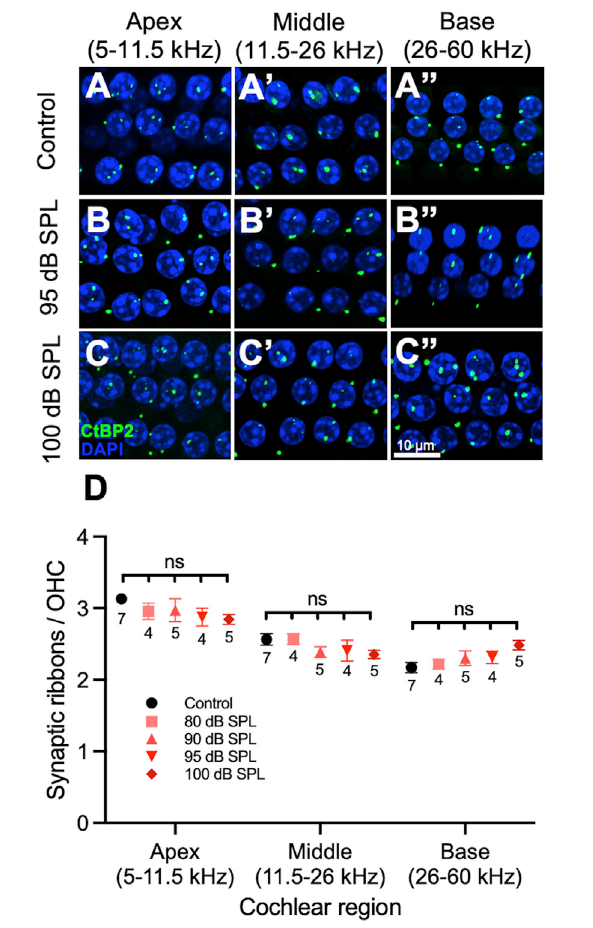
FIGURE 4 | 2 h noise exposure has no effect on outer hair cell (OHC) ribbons. (A – C) Representative sections from the organ of Corti of mice 7 days after noise or sham exposure (control) displaying 3 rows of 4 OHC nuclei and associated ribbons. Immunolabeling was performed to visualize OHC ribbons (CtBP2, green) as well as nuclei (DAPI, blue). Control mice (A) ,miceexposedto95decibel(dB) soundpressurelevelSPL (B) ,and mice exposed to 100 dB SPL (C) had similar numbers of ribbons per OHC. (D) Quanti fi cation of ribbons per OHC. There were no signi fi cant differences in the number of ribbons per OHC between mice exposed to 80, 90, 95, 100 dB SPL and control mice in any region of the cochlea. Data points represent means and error bars indicate standard error. Sample sizes are displayed under each data point and expressed in number of mice. All ribbon counts per OHC represent averages of both the right and left ears when available. ns (cid:1) not signi fi